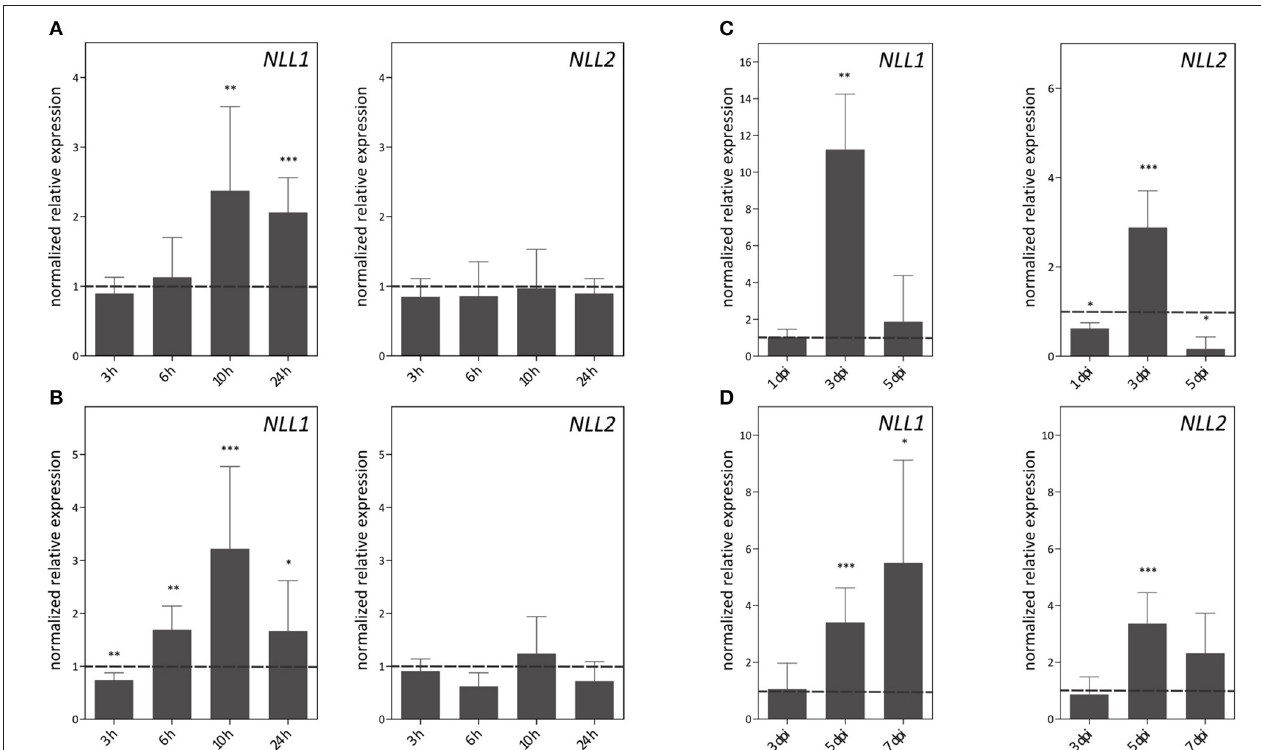
FIGURE 5 | Expression patterns of GmNLL1 and GmNLL2 under different stress conditions, determined by RT-qPCR. Expression patterns under salt stress on leaf (A) and root (B) material; (C) transcript levels in leaf material upon Phytophthora sojae infection and (D) Aphis glycines infestation. The normalized expression levels, relative to the control treatment (set to 1) at the indicated time points are shown. The mean values of RT-qPCR from three independent biological replicates were normalized to three reference genes and error bars indicate standard errors. Asterisks indicate statistically significant differences compared to